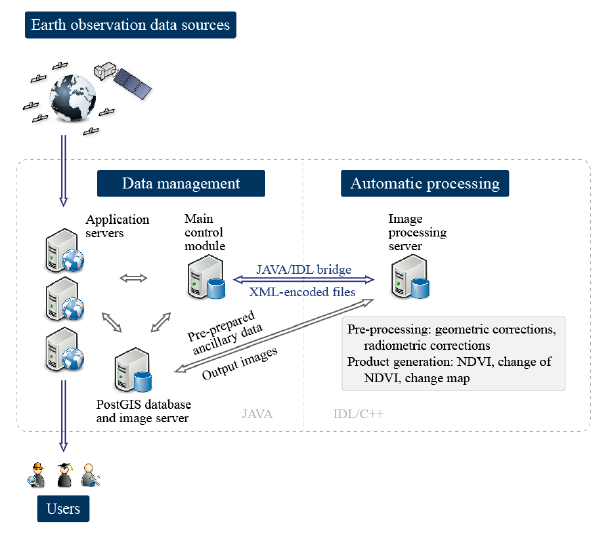
Figure 2. STORM processing chain architecture.